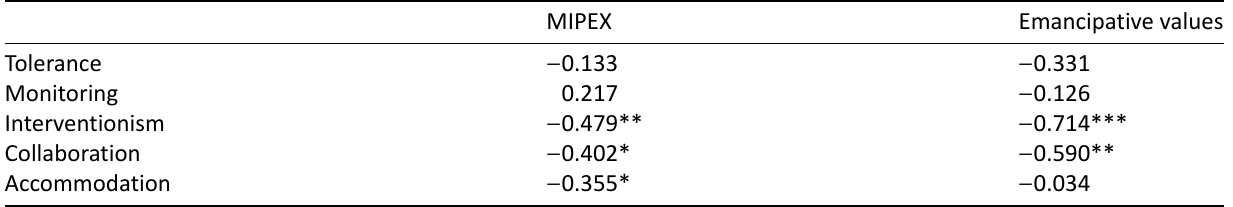
Table 2. Correlations between journalistic role perceptions and MIPEX and emancipative values.